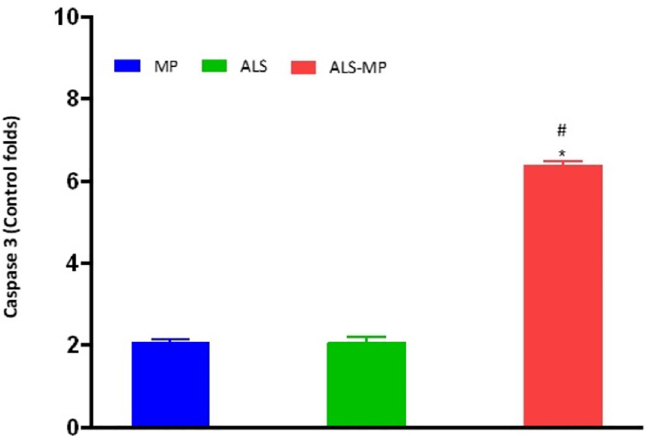
Fig 7. Comparative effects of ALS-MP on Caspase 3. � Significantly different from control p < 0.05, #significantly different from MP p < 0.05.